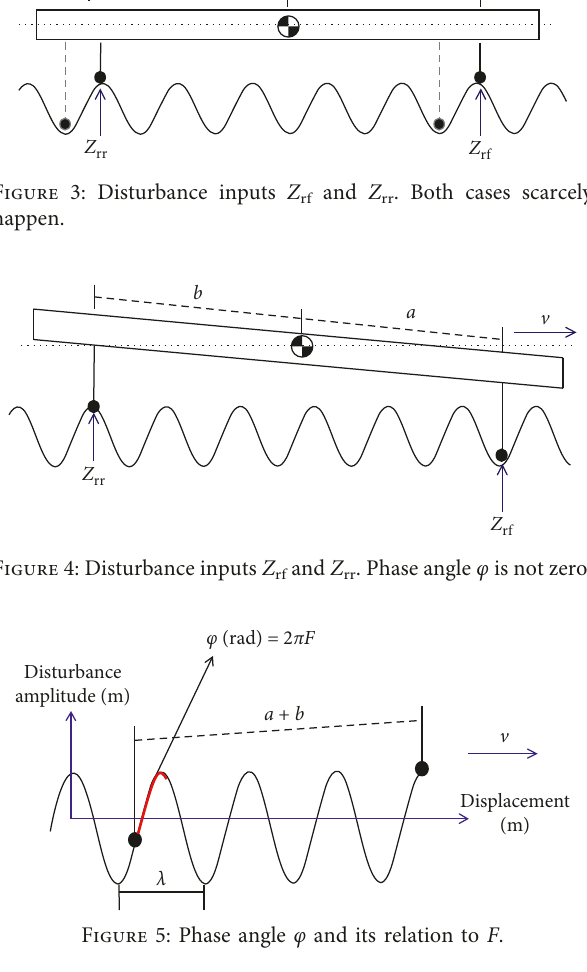
Figure 5: Phase angle φ and its relation to F